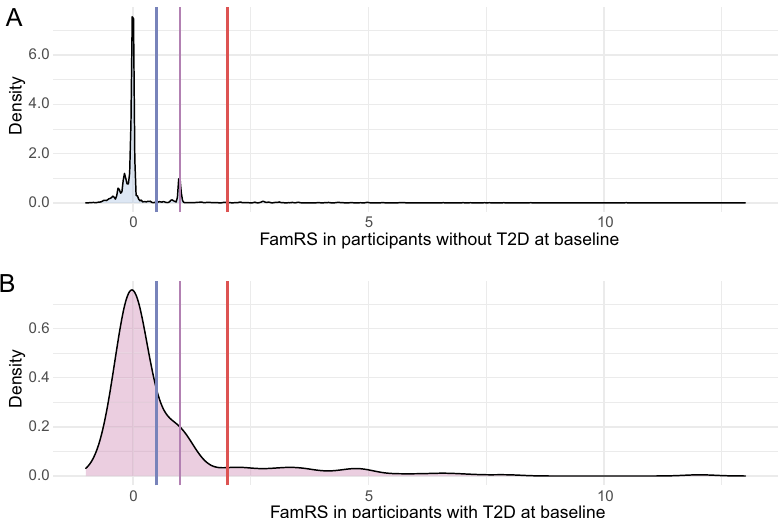
Figure 1. Density plot showing the FamRS distribution in participants without (lightblue, panel A ) and with T2D (pink, panel B ) at baseline; the lines depict the thresholds of the FamRS categories: positive family risk (blue line), strong positive family risk (purple), very strong positive family risk (red line).